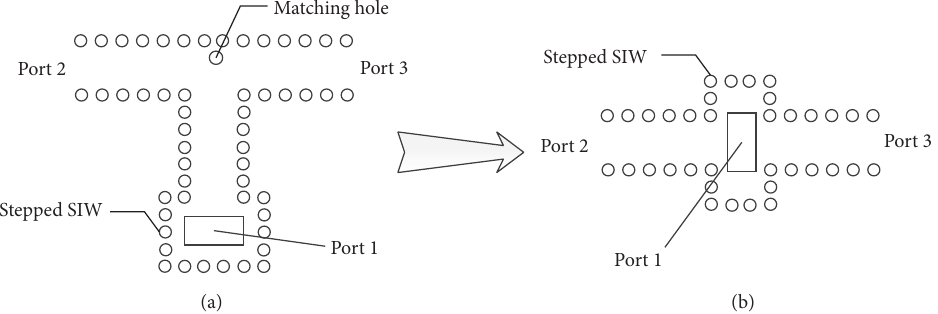
Figure 2: Different types of waveguide-SIW dividers. (a) Conventional structure; (b) proposed hybrid E-plane divider.